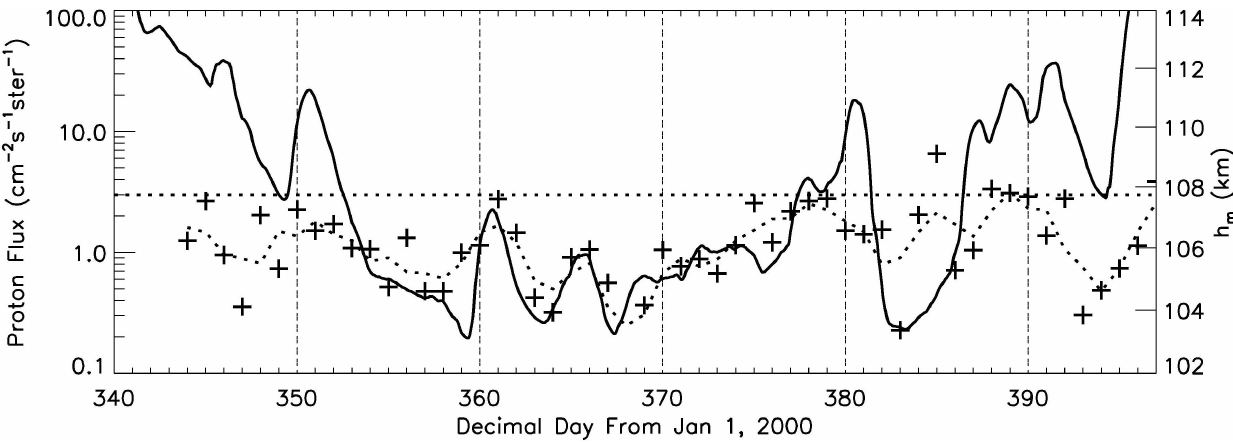
Fig. 1. The flux of protons with energy of 761 to 1220keV in the solar wind (solid curve) and the corrected altitude of the ionospheric electron density maximum (“+”) are plotted against the decimal day from 1 January 2000. The proton flux is obtained by ACE at the Earth’s orbit and the time is shifted 7 days due to the geometry of the Sun-Earth-Mars configuration (see text for details). The dotted curve is the 3-point running average of the